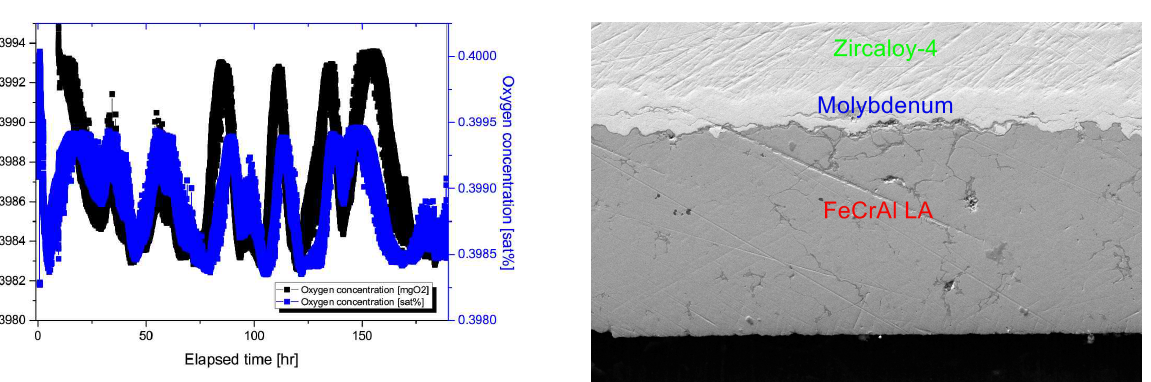
Figure 17. FeCrAl+Mo Run 3 - oxygen concentration.